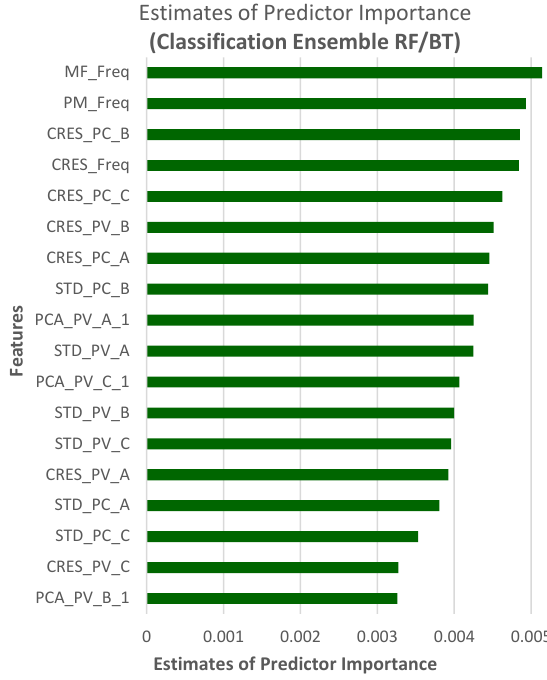
Figure 19. Predictor importance for FD using